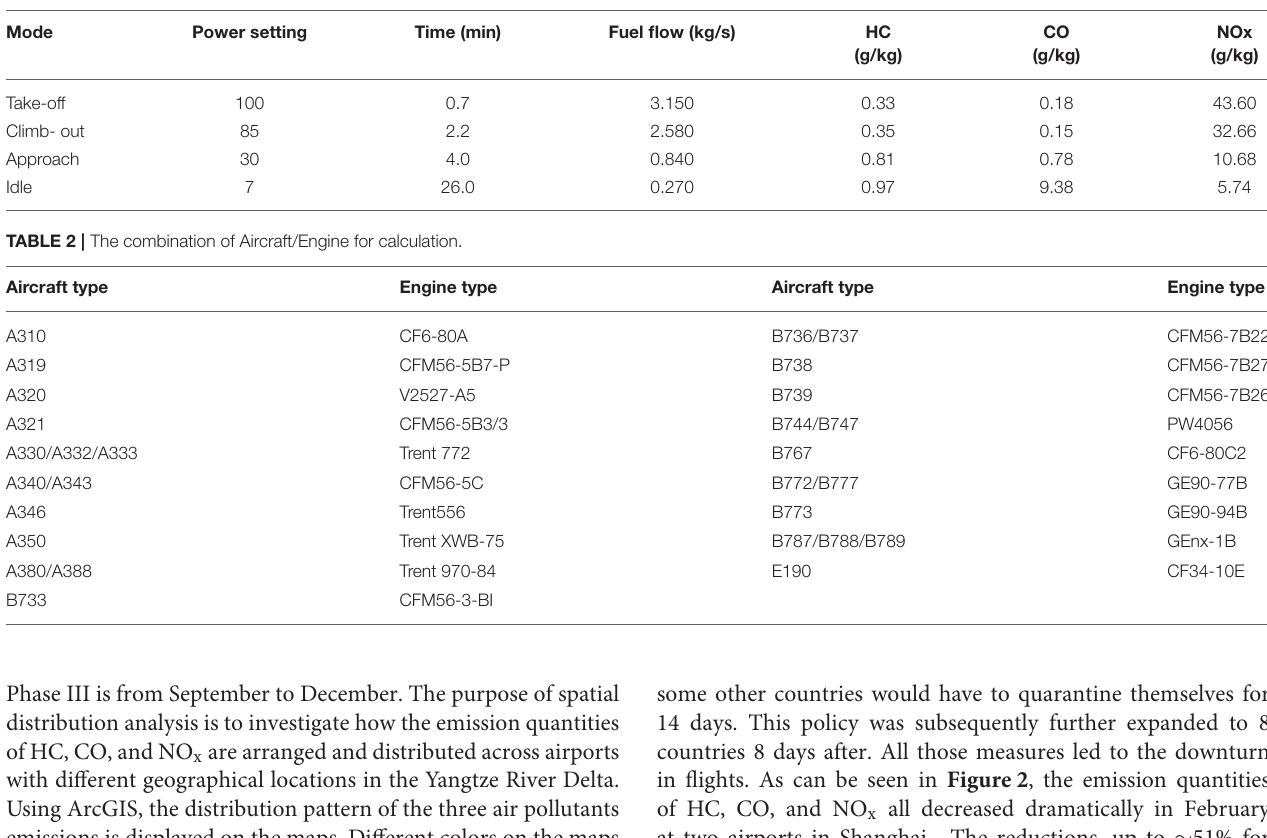
TABLE 1 | The measured data for Trent 772.